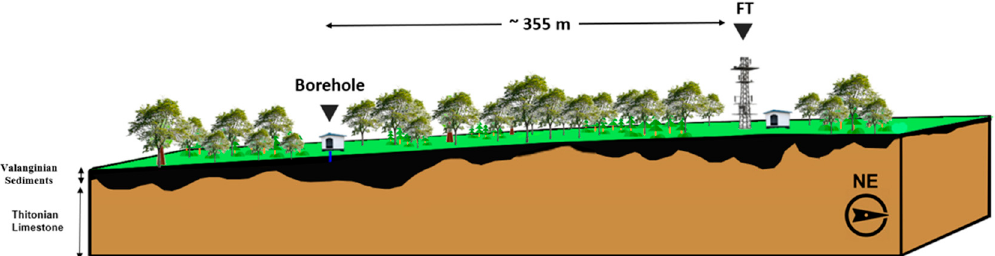
Figure 3. A vertical section of the soil profile of Tithonian limestone surmounted by valanginian sediments. On the surface, borehole measurement and a lattice tower (FT) were constructed with the distance around. 355 m .